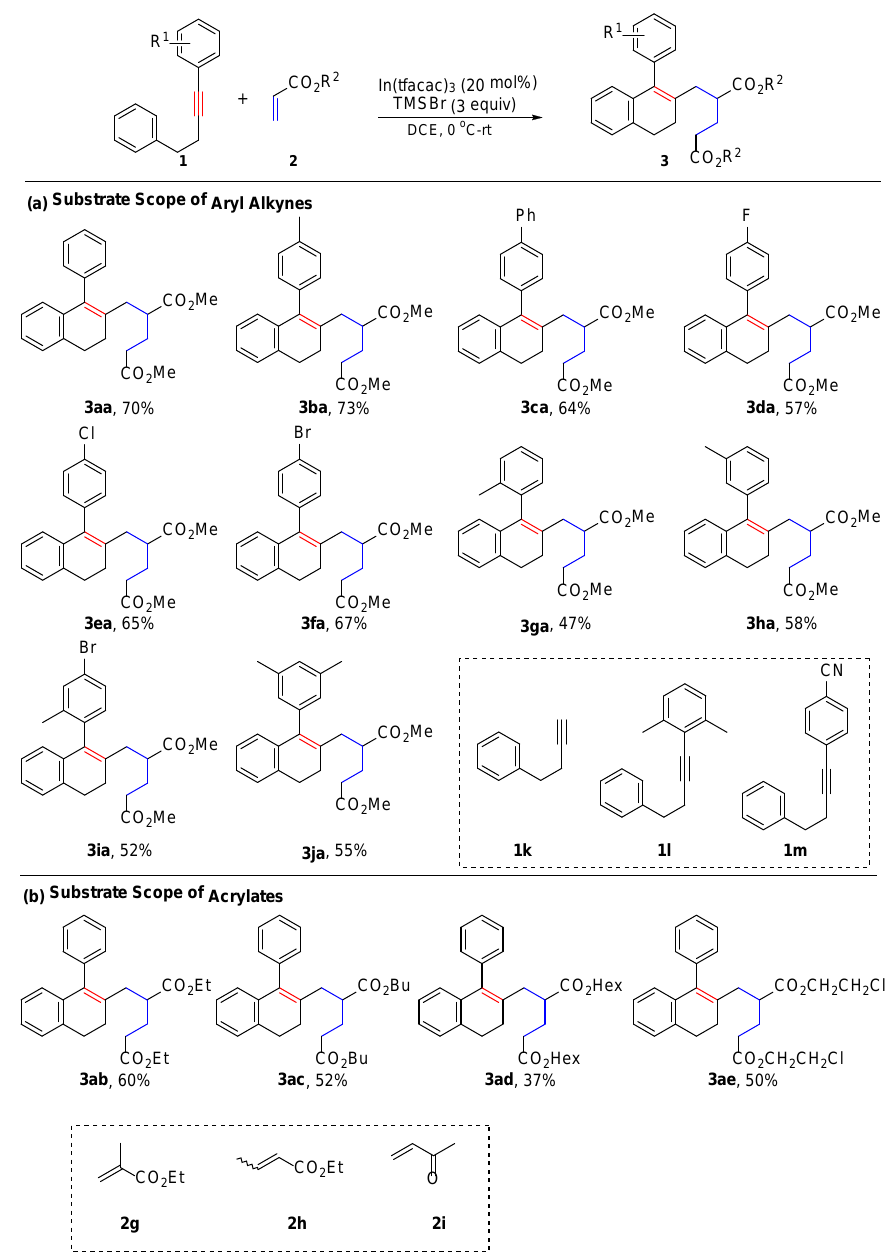
Figure 2. Substrate scope for the In(III)-TMSBr-catalysed cascade reaction of diarylalkyne with acrylates a,b . a Unless otherwise noted, all reactions were performed with 1 (0.4 mmol), 2 (1.2 mmol), In(tfacac) 3 (20 mol %), TMSBr (3 equiv), 0 °C-rt, N 2 . b Isolated yields.